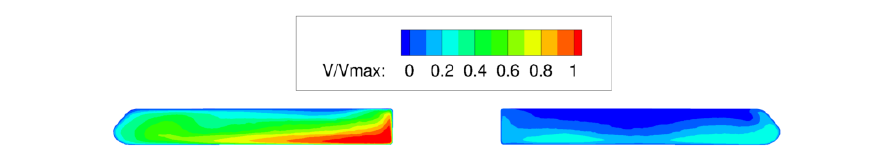
Figure 6. Normalized velocity at the actuator exit at the peak velocity phase (left nozzle), adopted from